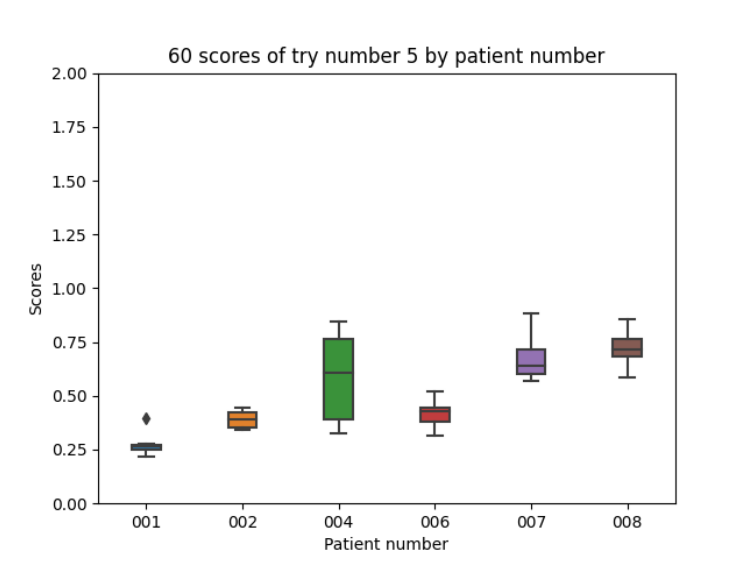
Figure 16. Experiment 5 boxplot scores, from 10 executions for each patient and configuration.